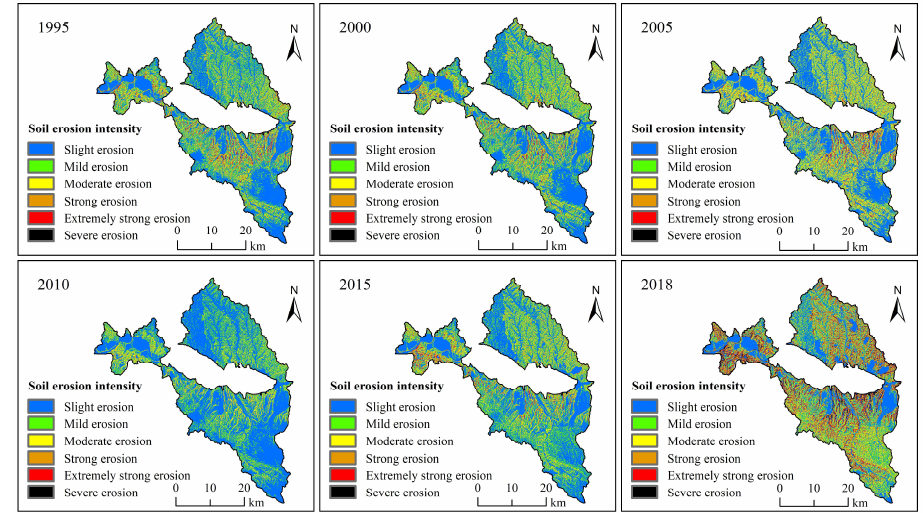
Figure 8. Spatial distribution of soil erosion intensity in the South and North Mountains of Lanzhou in 1995, 2000, 2005, 2010, 2015 and 2018.